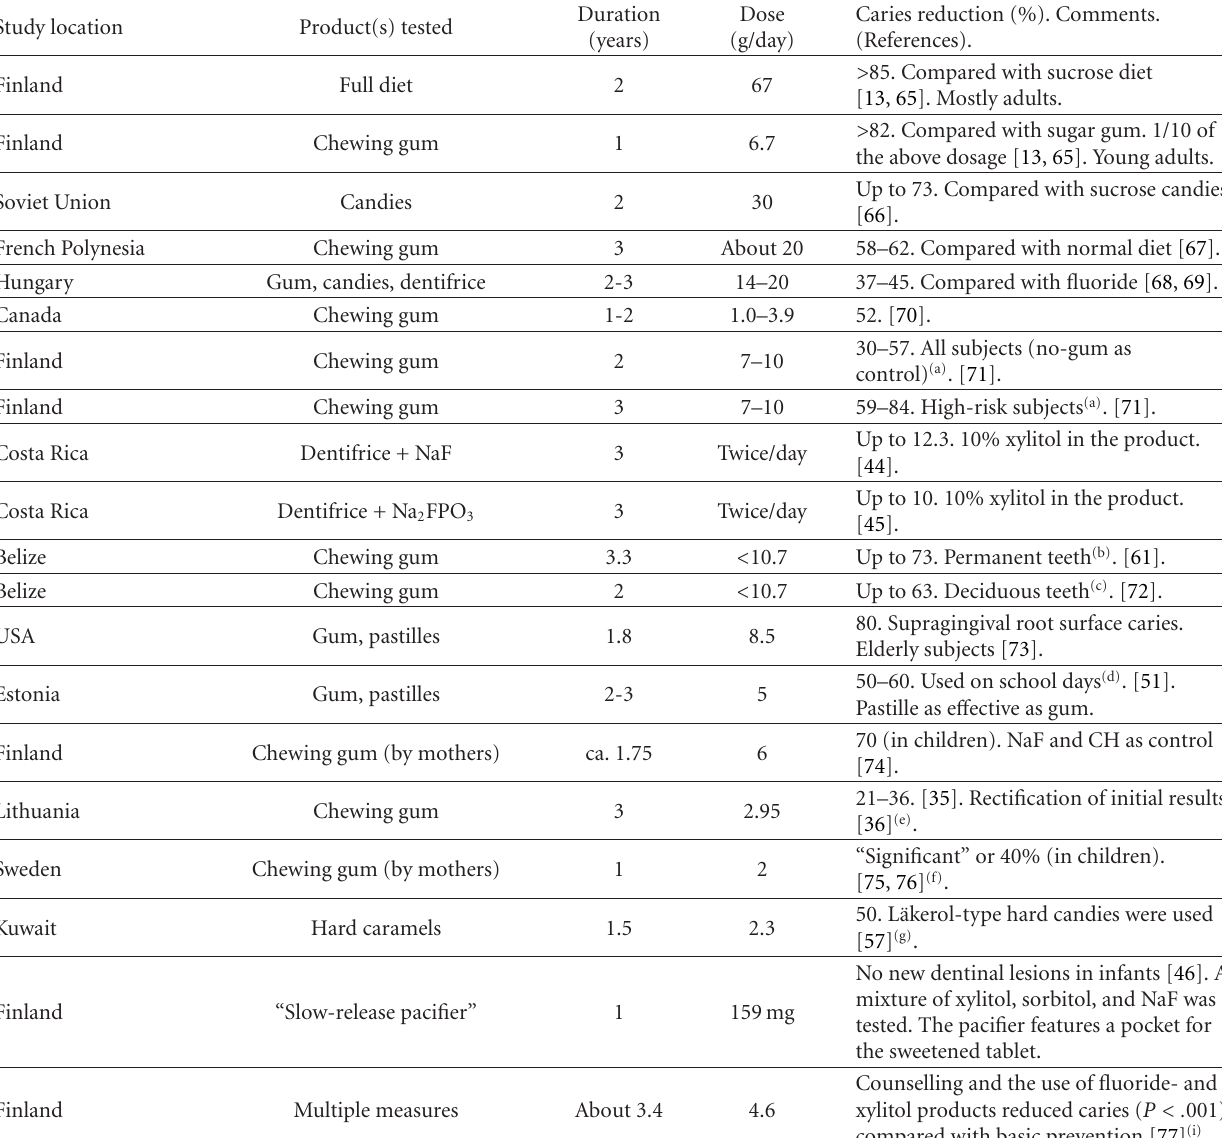
Table 1: Summary of human caries studies on xylitol that in part have constituted the justifications for public endorsements of xylitol. The percent-reductions are in comparison with a control group that received a normal diet, fluoride treatment, or sucrose products. Nondietary (dentifrice) studies and programs on multiple preventive measures that included the use of xylitol are also shown. CH =